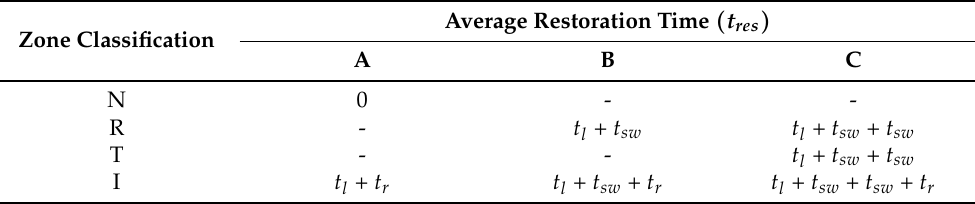
Table 1. Restoration time according to zone classification and protection or switching situation. Zone